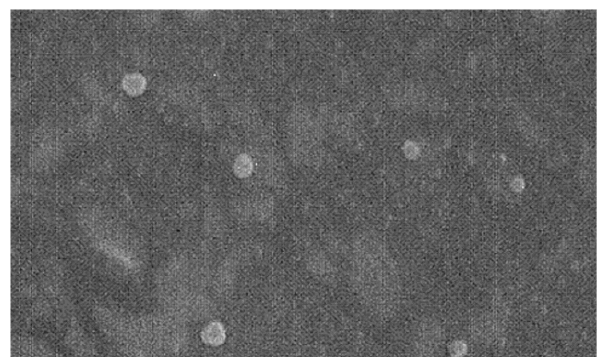
Figure 3. Scanning electronic microscopy (SEM) picture of SLN-CURC (Detector SE1, EHT 15.00 KV, Mag 10.00 KX, 500 nm).